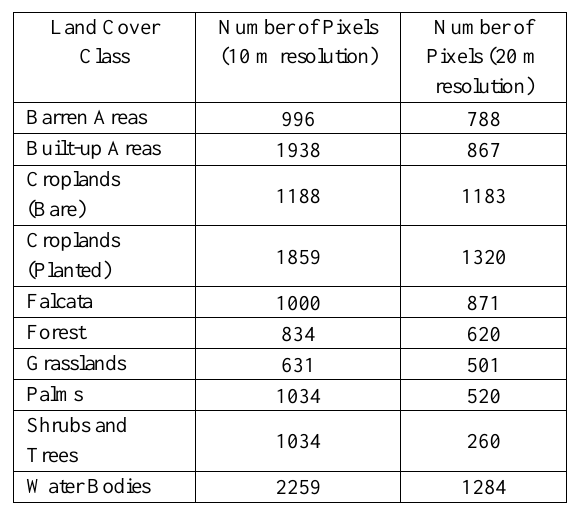
Table 1 . Number of pixels for classifier training.